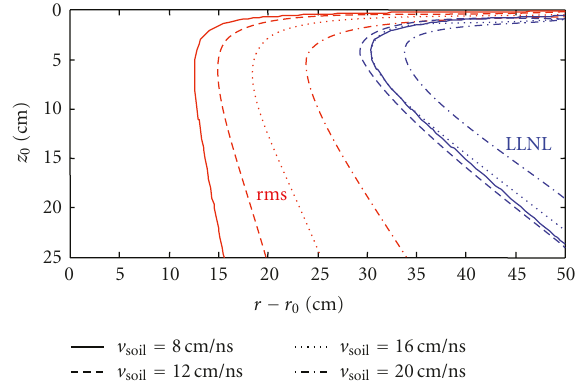
Figure 2: Migration aperture ( r − r 0 ) for the rms and the LLNL approximations as a function of z 0 (target depth). The antenna- medium distance is 10 cm, and the radar wave velocity into the medium is examined in the range from 8 to 20cm/ns. The aperture is limited to the contributions a ff ected by a phase error at the highest frequency (6GHz) lower than π/ 2.